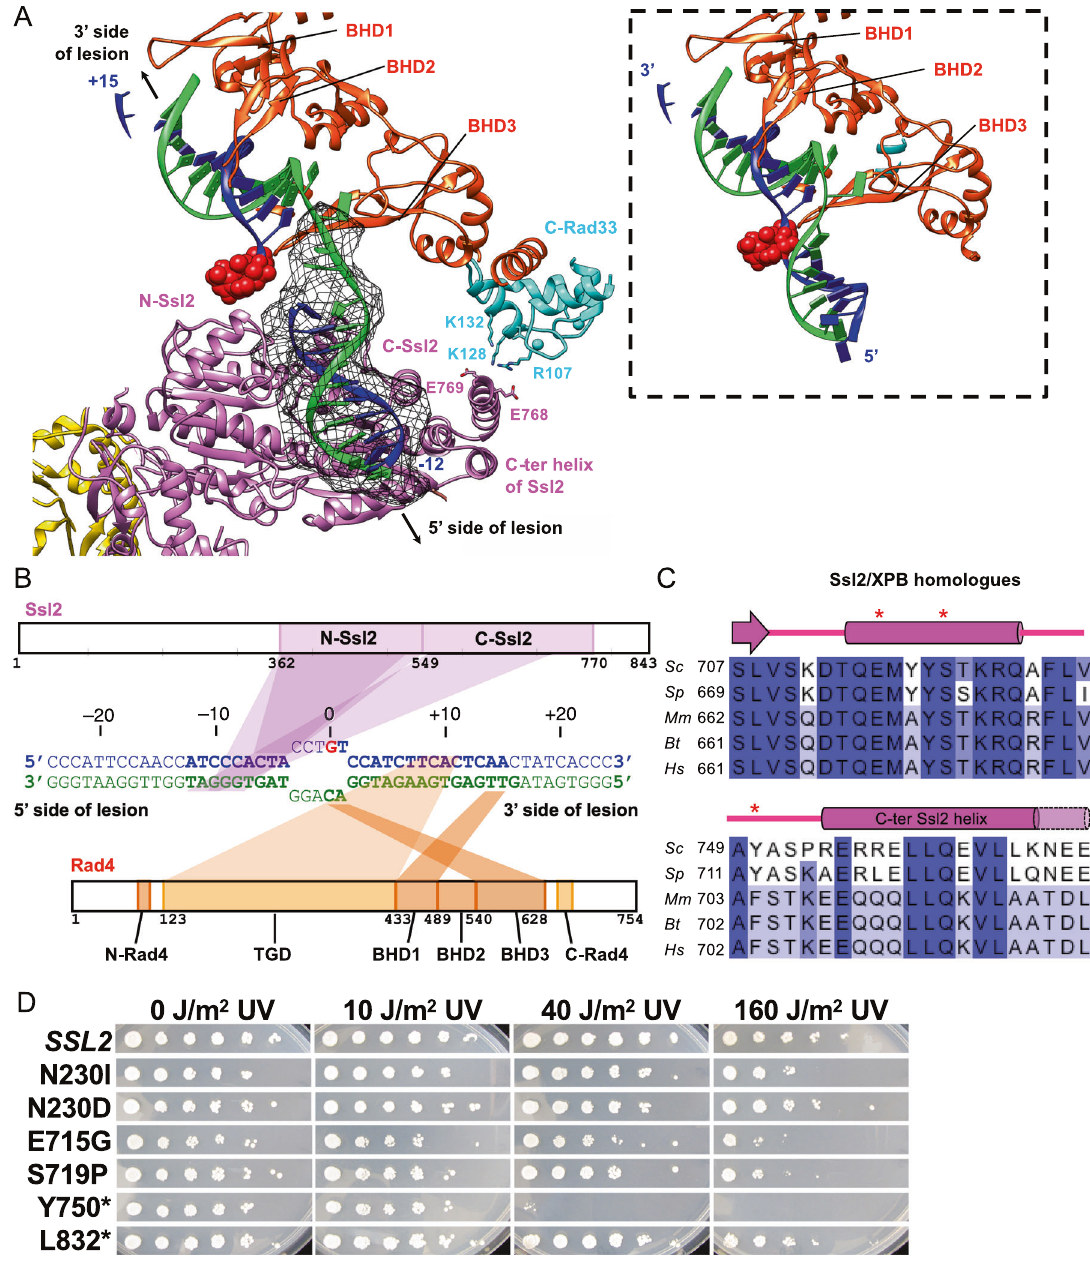
Fig. 5 Path of damaged DNA in TFIIH-Rad4/23/33-DNA complex. A Zoomed view of protein-DNA interactions at the lesion (red sphere). ~9-bp DNA segment 5' side of the lesion (black mesh) was identi fi able on Ssl2 after multibody re fi nement of Map 2. This segment of dsDNA is untwisted ~150° compared to that in Rad4 – Rad23/DNA (PDB:6CFI, inset), enabling simultaneous binding to Rad4 and Ssl2. Map threshold at 0.0013, σ = 3.4 with segmentation 4 Å from DNA model. B Schematic diagram of protein-DNA interactions suggested by the model. Nucleotide numbering follows the 5' – 3'- direction on the damaged strand (blue) with respect to the AAF-dG at position + 0. Nucleotides in the model are in bold. C Sequence alignment of C- Ssl2 and XPB with secondary structures between Saccharomyces cerevisiae (Sc), Schizosaccharomyces pombe (Sp), Mus musculus (Mm), Bos taurus (Bt), and Homo sapiens (Hs). Dots indicate positions for mutations of Ssl2 in (D). D Mutations of Ssl2 at the interface with Rad33 and Tfb5 confer UV sensitivity. Yeast cultures grown in YPD were diluted and plated. Uncovered plates were then irradiated with UV light (254 nm) at the indicated doses followed by incubation for 3 days. Asterisks indicate C-terminal deletion mutants at indicated Mutations of Ssl2 adjacent to the interface with Rad33, Tfb5, in good agreement with localization of the binding sites for Rad33 and Tfb2 confer UV sensitivity . To examine the structure- and Rad14 in this region (Fig. 5C, D). Two additional alleles, function relationship in vivo, a subset of novel ssl2 alleles defec- E715G and S719P, which are located near or at the interface with tive in transcription initiation 72 were screened for UV sensitivities Tfb5 and Tfb2 (Supplementary Fig. 6), have moderate UV sen- (Fig. 5C, D). The mutant allele Y750 * , a reconstruction of the sitivity. Other ssl2 mutants were either not or were much less mutant allele SSL2-XP 72,73 that eliminates 94 C-terminal amino sensitive to UV light, suggesting separation of NER and acid residues (residues 750 – 843), confers extreme UV sensitivity, transcription-related functions, or a much greater sensitivity of